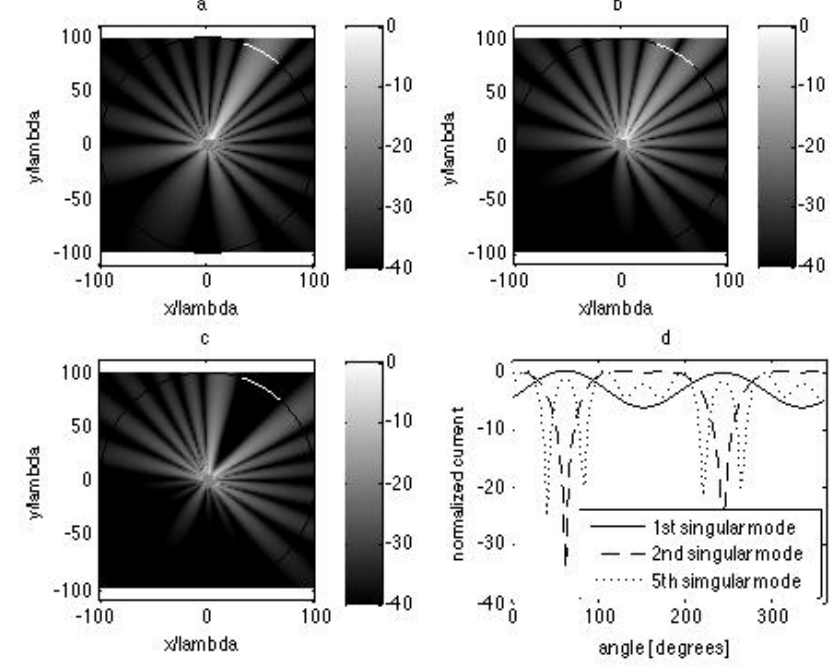
Figure 3. Singular mode field amplitude and currents; in ( a – c ) the circle having R = 100 λ radius is plotted as a black curve (barely visible); the observation arch is plotted as white curve ( a ) 1st singular mode amplitude; ( b ) 2nd singular mode amplitude; ( c ) 5th singular mode amplitude; ( d ) normalized singular mode currents, solid line: 1st, dashed line: 2nd mode, dotted line: 5th mode